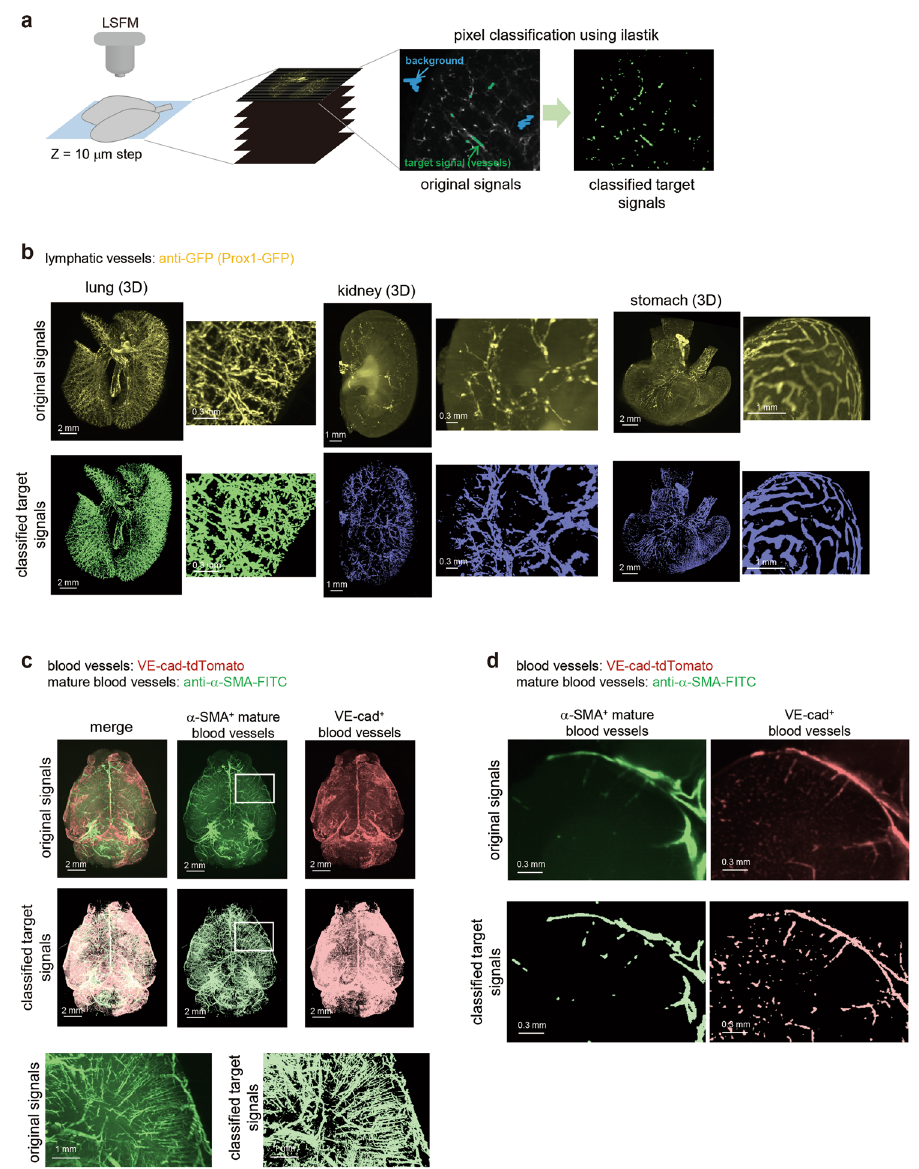
Fig. 3 | Evaluation of 3D images with computational training. a Overview of analysis procedure of pixel classi fi cation. The 3D images of transparent samples werecapturedby LSFM. Thecaptured tiff images wereconvertedto hdf5format usingpython.Targetsignalssuchasvasculatureorcancercellswereclassi fi edby machinetrainingwithilastiksoftware.Inthisstudy,twoclasses(targetsignaland background) were de fi ned for the classi fi cation. b The images of the original signals and classi fi ed target signals after training by ilastik. The 3D whole-organ images of the original fl uorescent signals (upper) and classi fi ed signals after machine learning (lower) are shown (lung, kidney, and stomach). The sample of